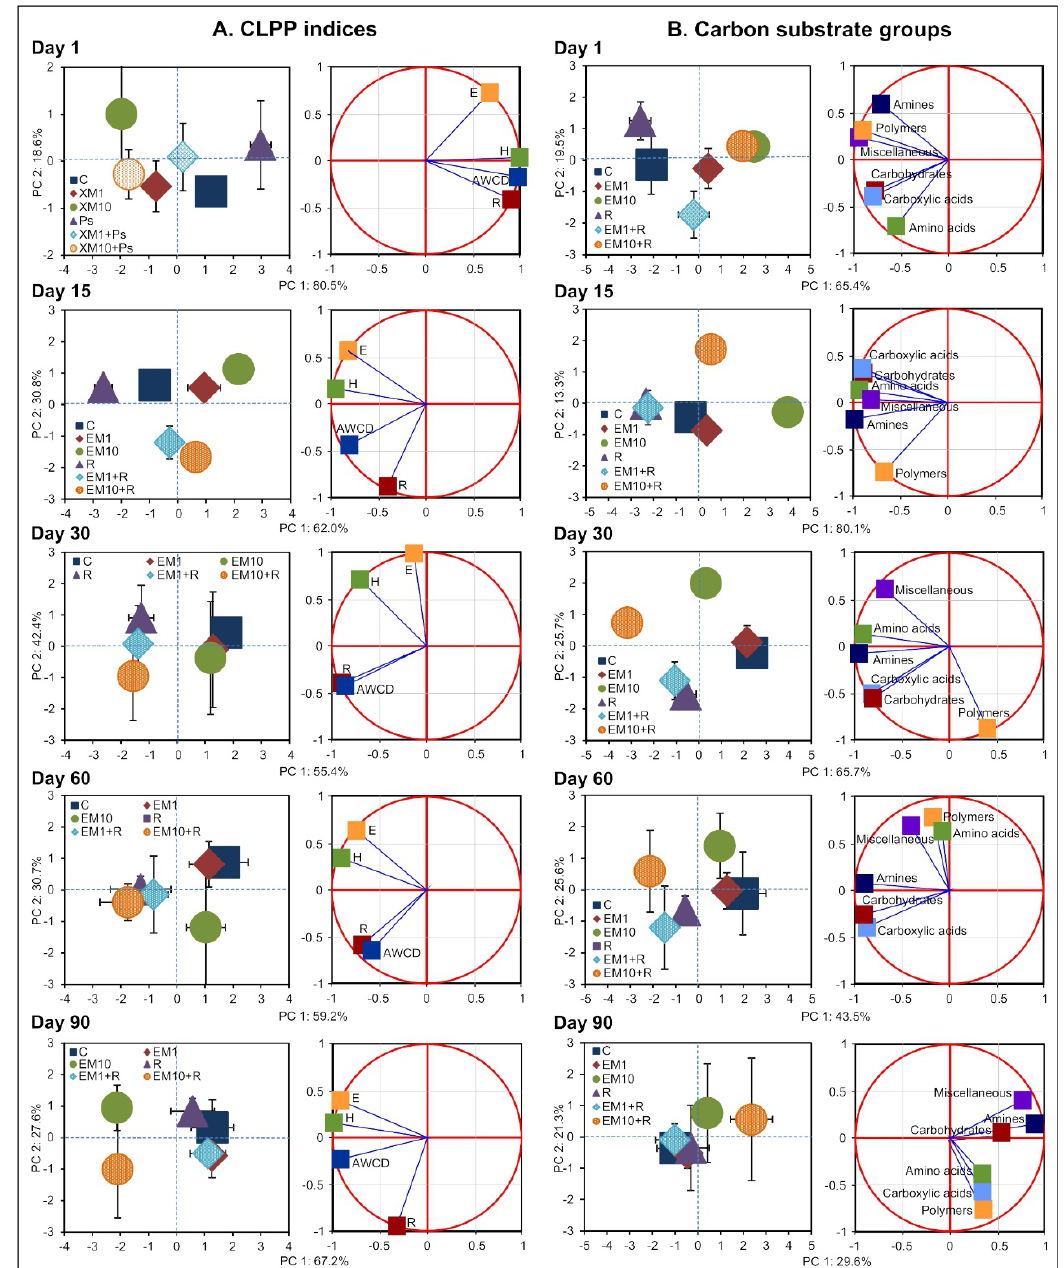
Figure 6. The PCA plots for the CLPP indices ( A ) and carbon substrate groups ( B ) generated for each sampling day of the experiment. The treatment abbreviations are explained in Figure 2.